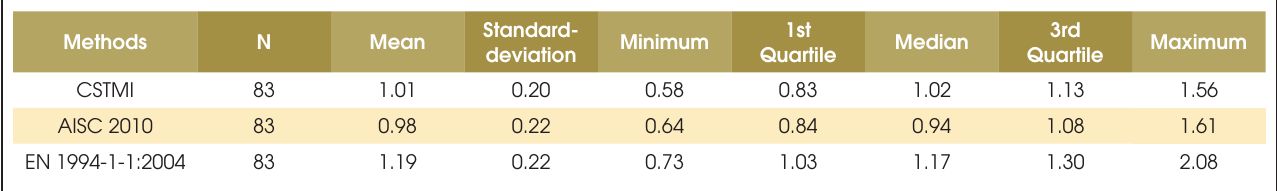
Table 2 – Mean values of the R ratio for comparisons between the composite columns tests, implemented, and standards procedures